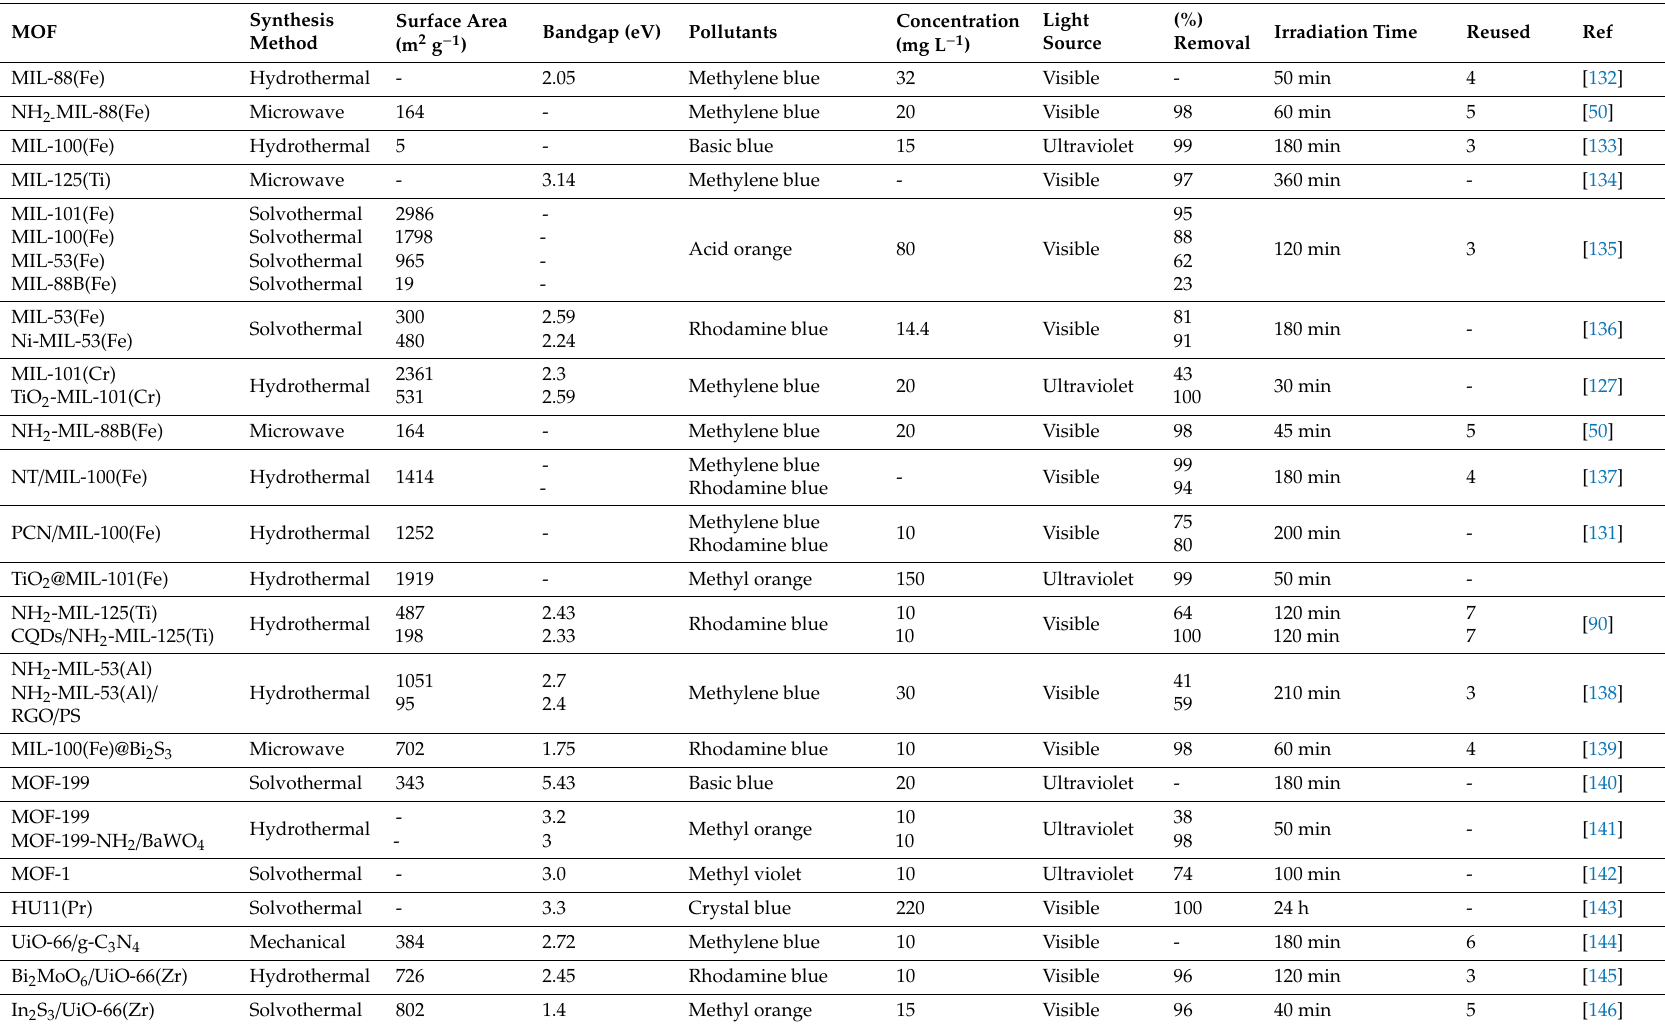
Table 2. MOFs and MOF composites for the photocatalytic degradation of